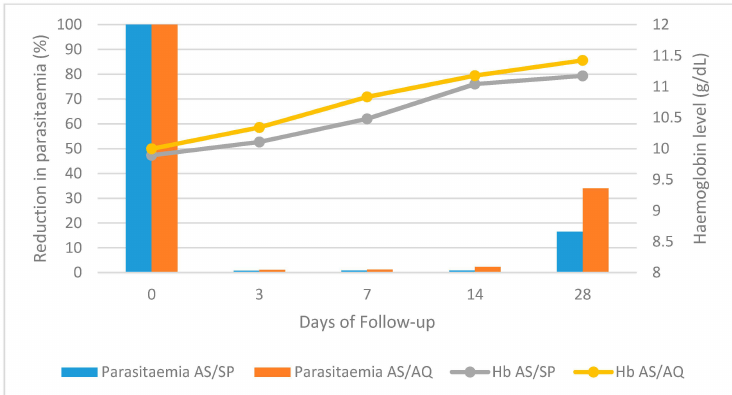
Figure 2. Reduction in mean temperature and proportion of fever cases in the course of treatment.